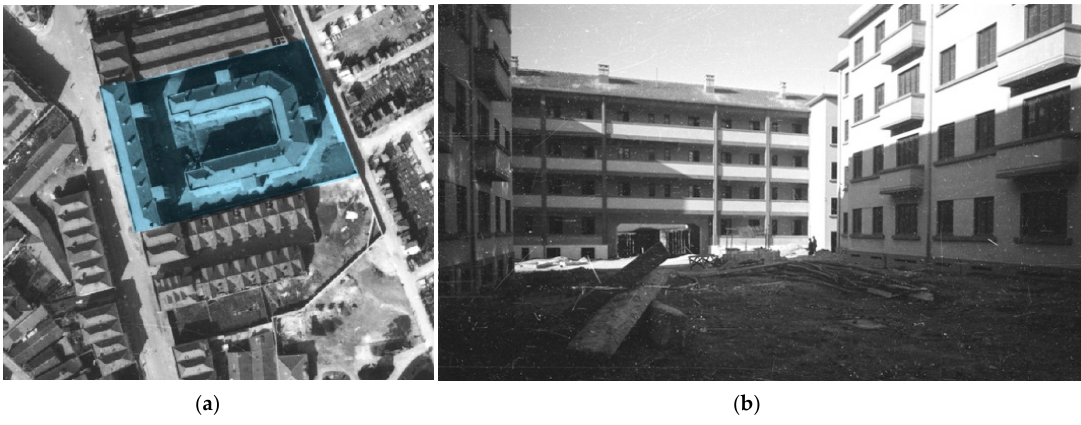
Figure 3. Multistory Residential Building at Rua Duque de Saldanha, Porto, Portugal ( a ) Aerial view, circa 1939; ( b ) Courtyard view—Photographic survey of construction circa 1937.